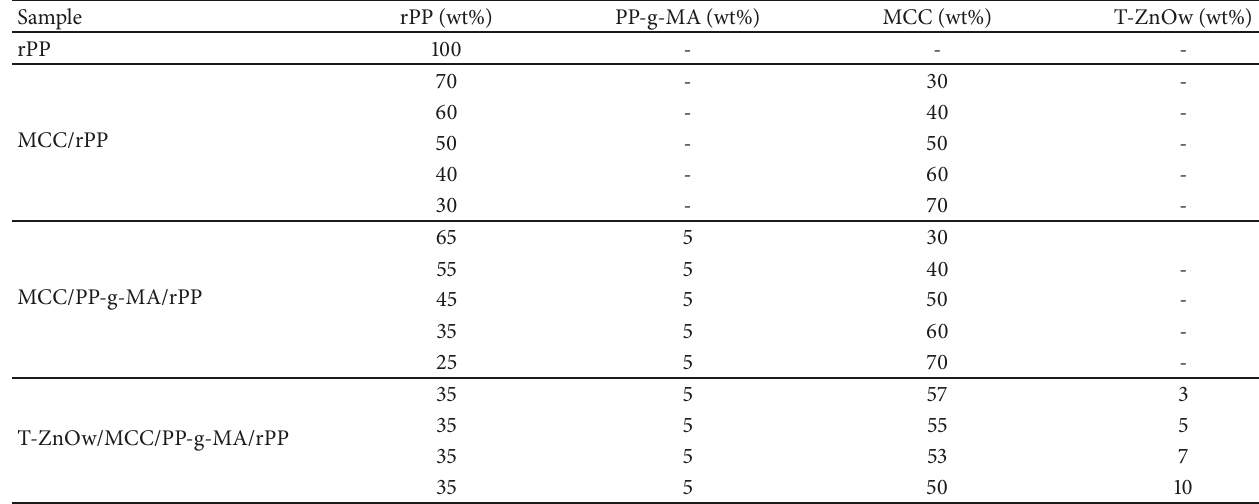
Table 1: Components and preparation of